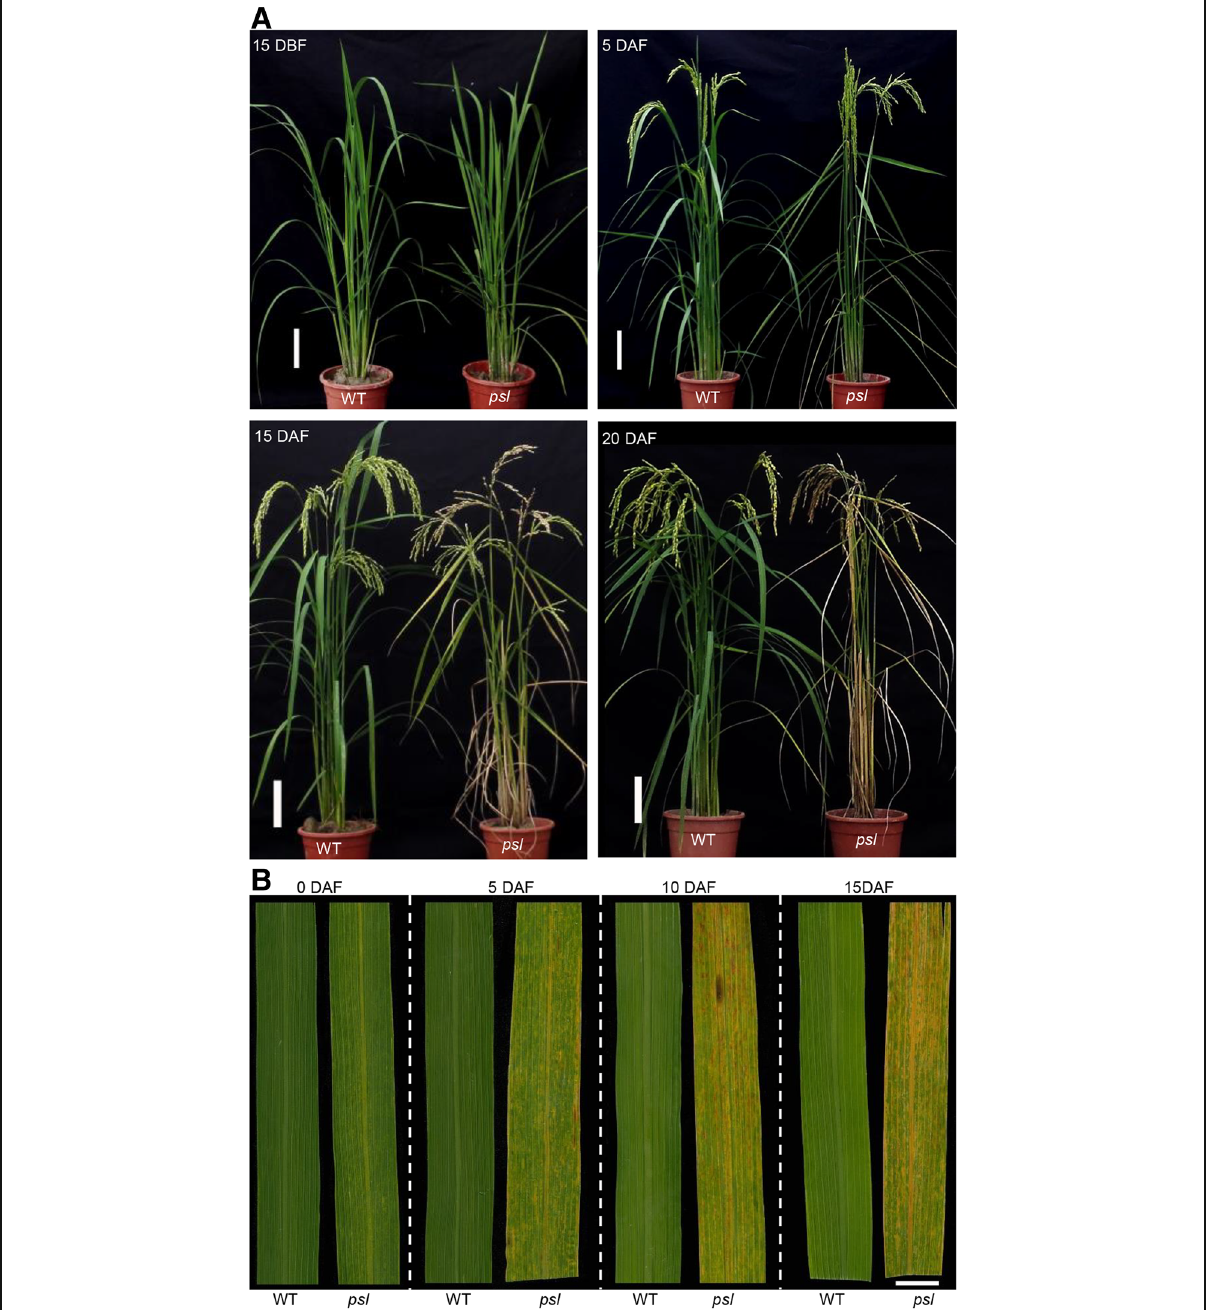
Fig. 1 Phenotype of the psl mutant. a Comparison of leaf phenotype in wild-type and psl mutant plants at different developmental stage. b Comparison of lesion mimic phenotype in wild-type leaves and psl mutant leaves. DBF: days before flowering; DAF: days after flowering. Bar = 10 cm in (A) and 1 cm in